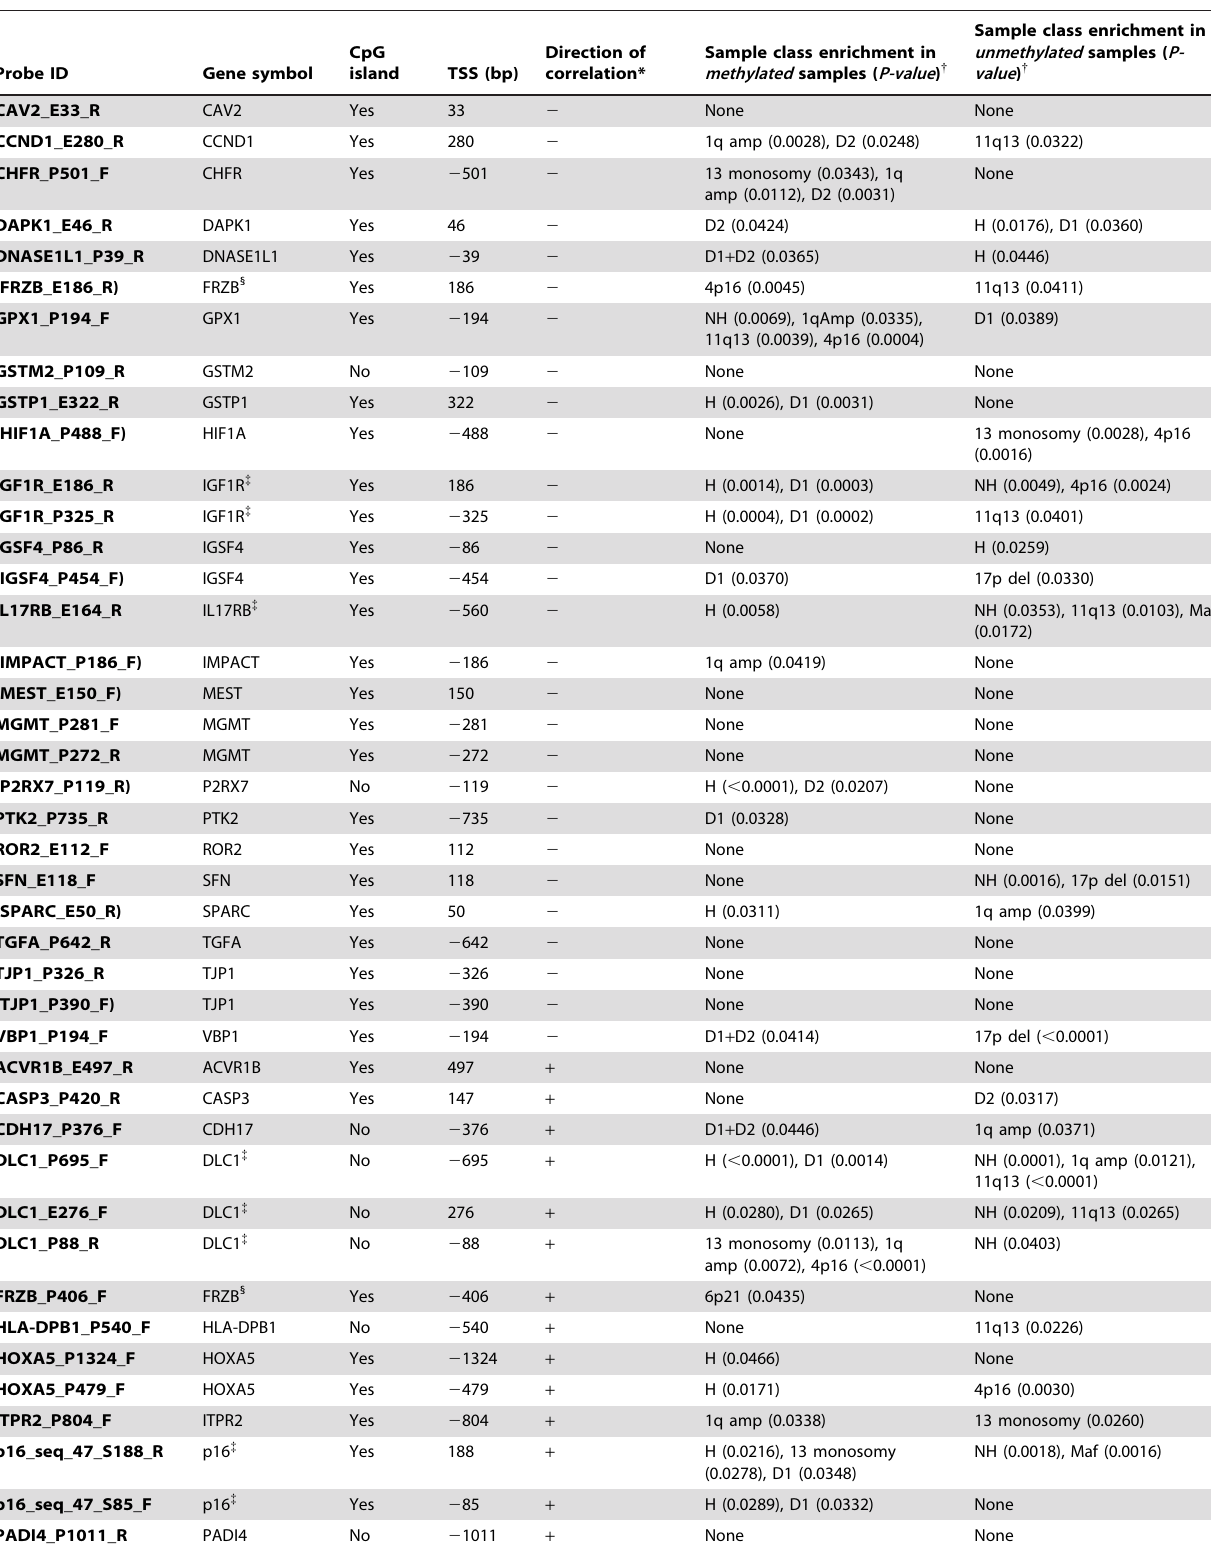
Table 4. Top 40 methylation loci with statistically significant methylation-expression correlations using the discretization approach .